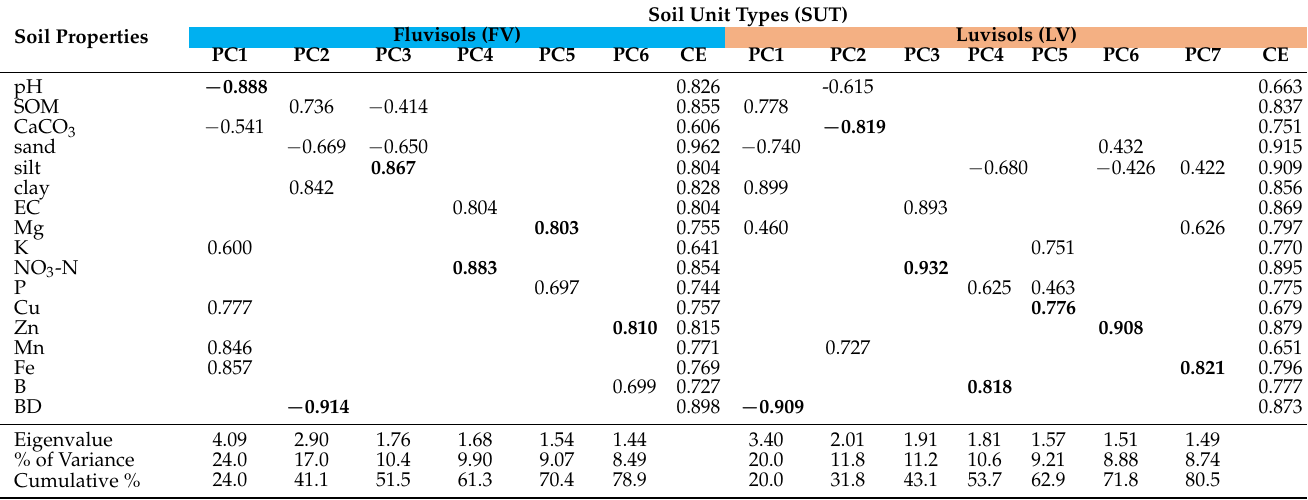
Table 7. Results of the principal component (PC) analysis of soil properties for different soil units (SU).